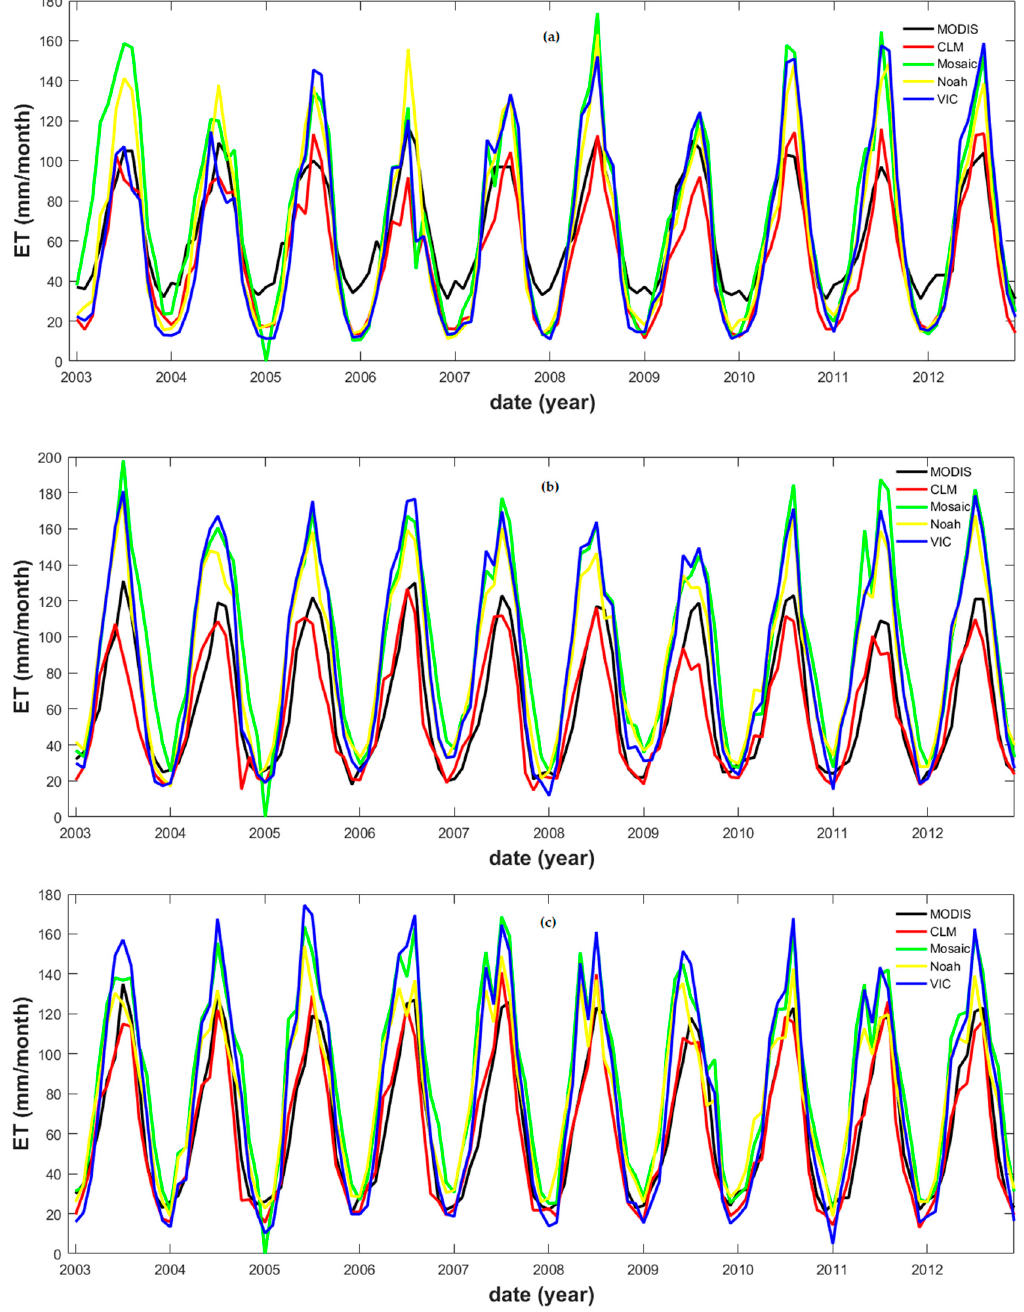
Figure 5. MODIS and GLDAS modeled evapotranspiration time series in correspondence of ( a ) Pingshan (upper reaches), ( b ) Chenglingji (middle reaches), and ( c ) Datong (lower reaches) stations. Table 4. Statistical comparison between remotely sensed MODIS evapotranspiration and the GLDAS modeled evapotranspiration data at the three selected stations along the upper, middle, and lower reaches of the Yangtze River basin.